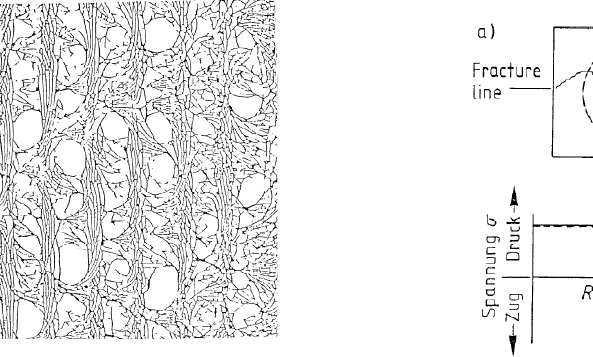
Figure 3a and b: Typical fracture lines of the product “VISURIT” [2] and simplified model to explain the thermal membrane